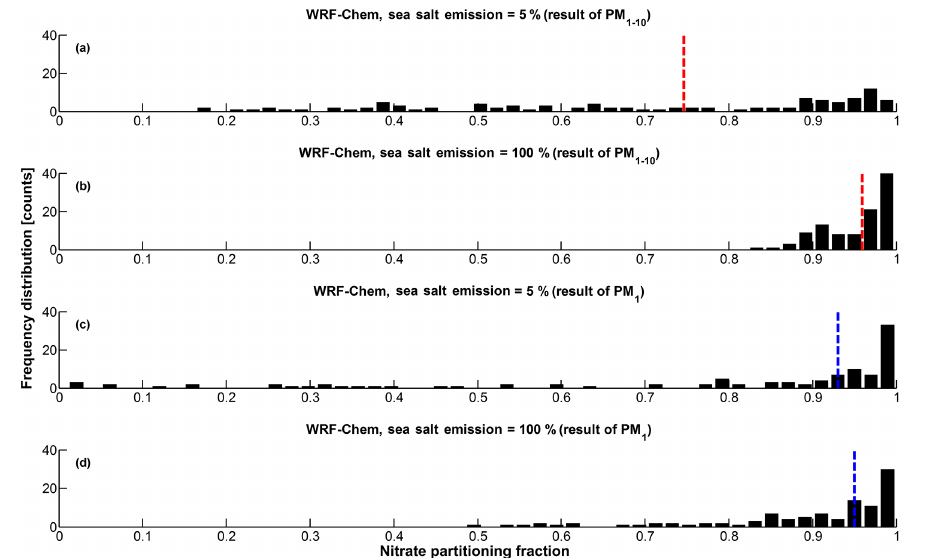
Figure 10. WRF-Chem results of the frequency distribution of PF_nitrate at Melpitz. The results were analyzed during the marine period ([Na + ]>1.8µgm 3 in the F-CASE). The dash lines (coarse mode: red; fine mode: blue) indicate the median value (with 50% probability in both sides). (a) R-CASE result of the size range PM 1 − 10 ; (b) F-CASE result of the size range PM 1 − 10 ; (c) R-CASE result of the size range PM 1 ; (d) F-CASE result of the size range PM 1 .